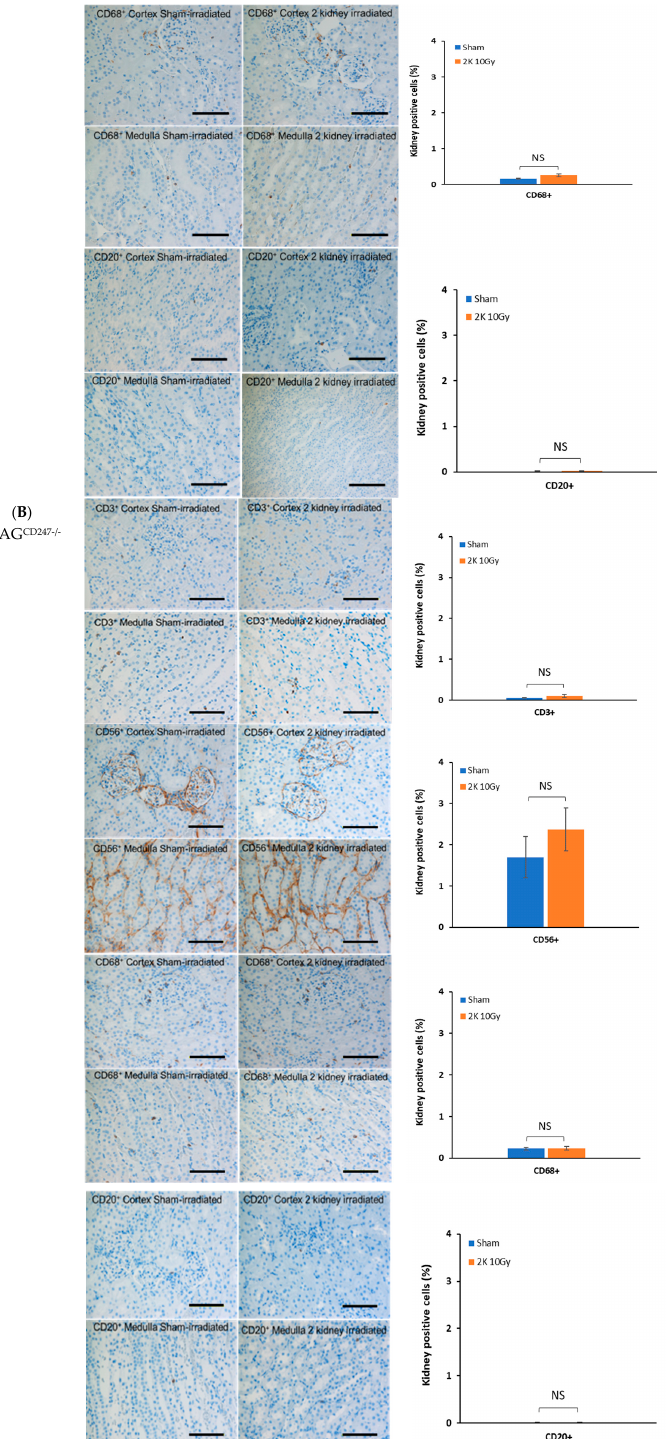
Figure 7. days after local irradiation with 10 Gy of X-rays in A. wild-type WAG and B. WAG CD247-/- Figure 7. Immune cells in cortex and medulla of kidney 40 days after local irradiation with 10 Gy of rats. T cells (CD3 + ), natural killer cells (CD56 + ), macrophages (CD68 + ) and B cells (CD20 + ) appear as brown color. The horizontal scale bar represents 100 microns. Images are representative data from X-rays in A. wild-type WAG and B. WAG CD247-/- rats. T cells (CD3 + ), natural killer cells (CD56 + ), 3–4 animals per group. Quantification of immune cells in kidney. Data are mean + SEM. macrophages (CD68 + ) and B cells (CD20 + ) appear as brown color. The horizontal scale bar represents Renal collagen content was measured over the area of the entire kidney by trichrome 100 microns. Images are representative data from 3–4 animals per group. Quantification of immune staining and expressed as a percentage of the total area of the kidney section. There was cells in kidney. Data are mean + no increase in kidney collagen content after local irradiation with 10 Gy of X-rays in wild- type WAG or WAG CD247-/- rats at 40 days (Figure 8). There was no tubule depletion follow- ing local irradiation with 10 Gy of X-rays in wild-type WAG and WAG CD247-/- rats at 40 days (Figure 8). Thus, early radiation nephropathy as indicated by elevated BUN levels on day 40 (Figure 5) is not associated with the engagement of immune cells or induction of fibrosis.